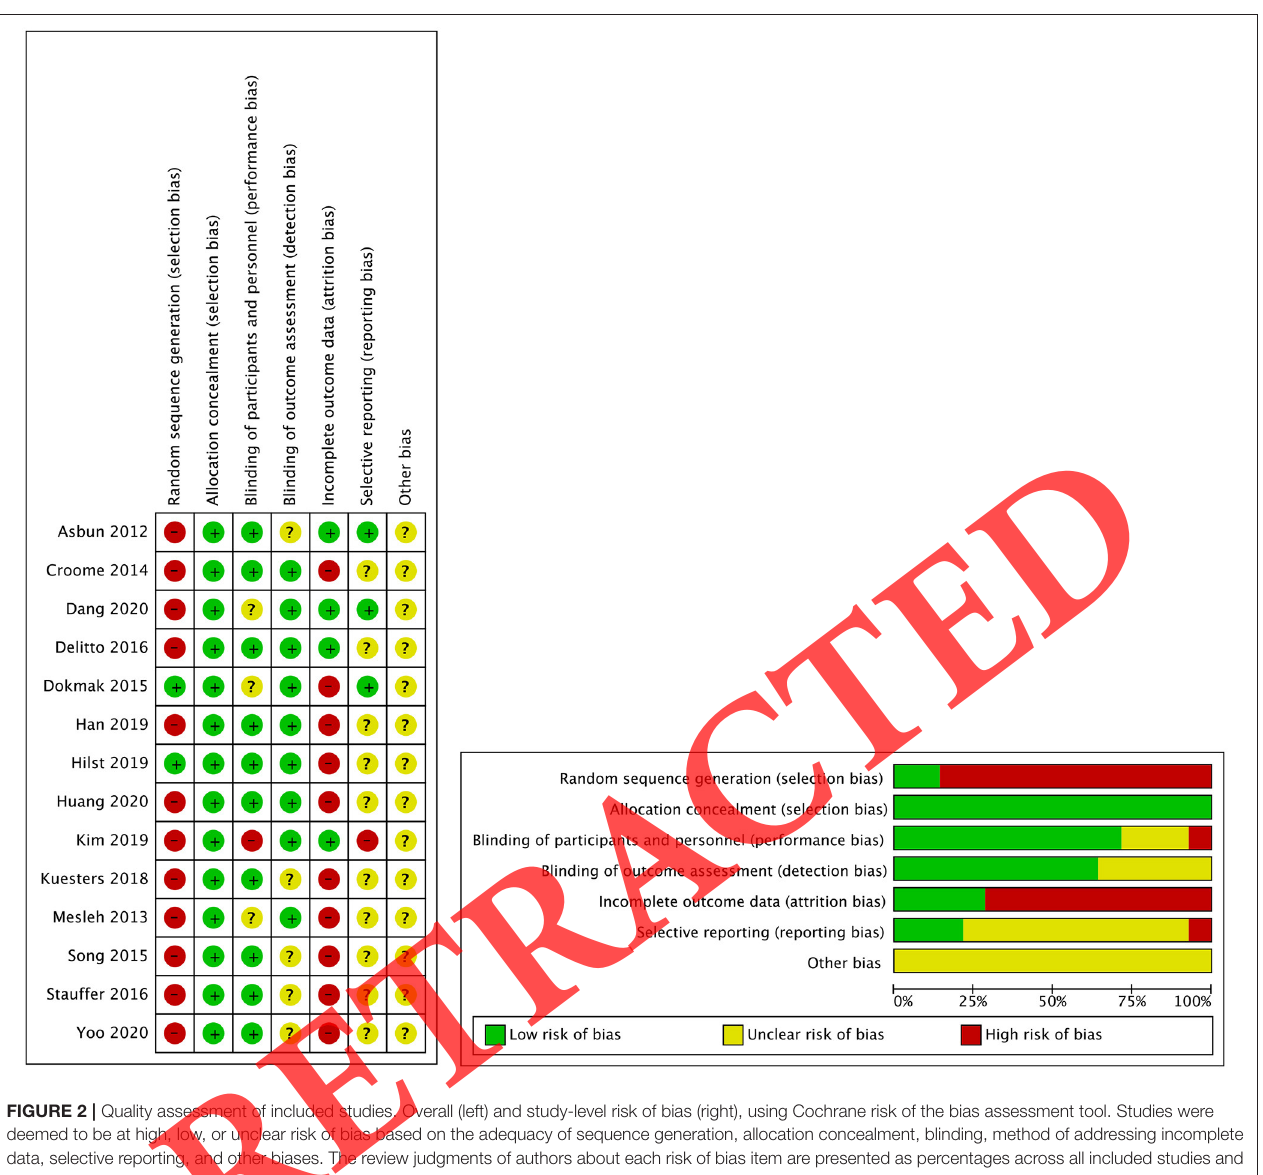
FIGURE 2 | Quality assessment of included studies. Overall (left) and study-level risk of bias (right), using Cochrane risk of the bias assessment tool. Studies were deemed to be at high, low, or unclear risk of bias based on the adequacy of sequence generation, allocation concealment, blinding, method of addressing incomplete data, selective reporting, and other biases. The review judgments of authors about each risk of bias item are presented as percentages across all included studies and for each included